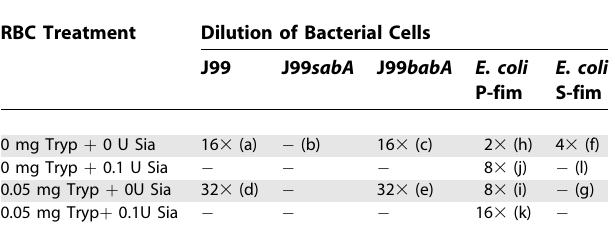
Table 2. Bacterial HA of Enzyme-Treated Erythrocytes RBC Treatment Dilution of Bacterial Cells J99